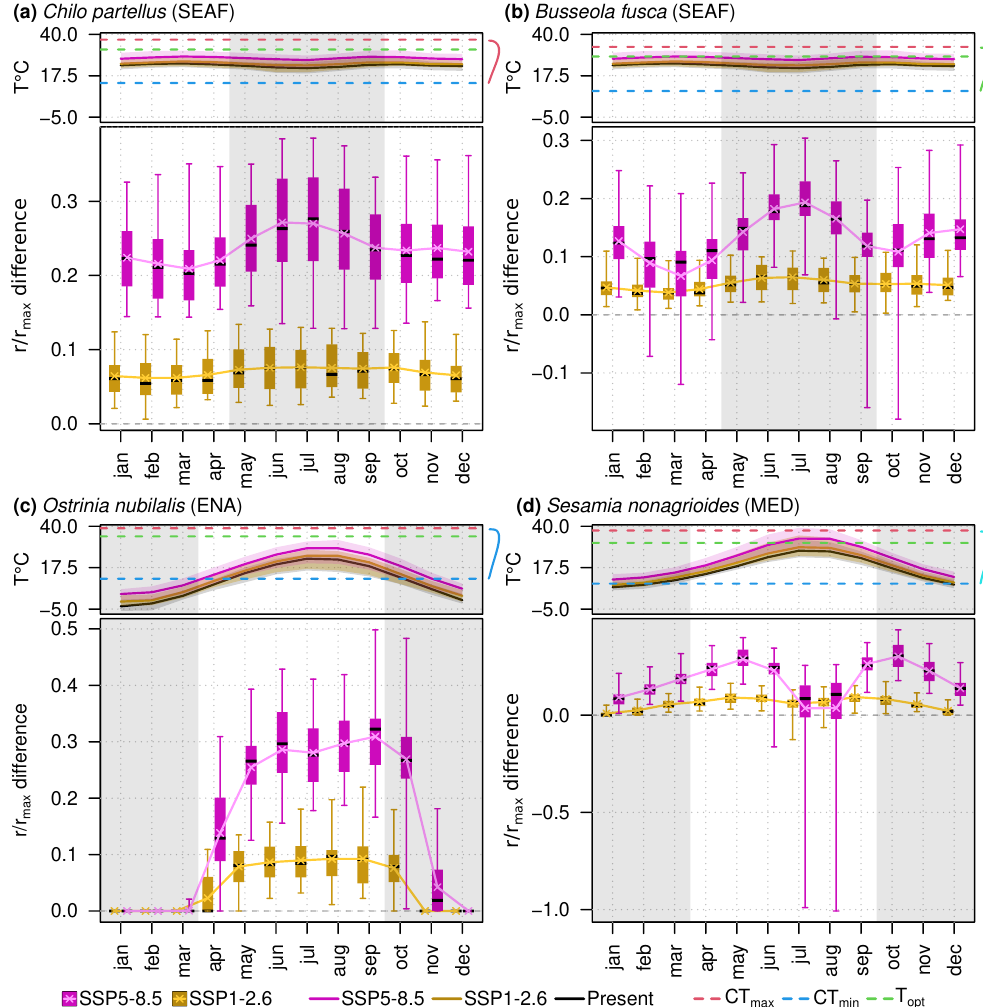
Figure 6. Influence of global warming on the development of ( a ) Chilo partellus , ( b ) Busseola fusca , ( c ) Ostrinia nubilalis , and ( d ) Sesamia nonagrioides . For each species, we predicted average devel- opment rates using mean monthly temperatures predicted by multiple Global Circulation Models (GCM) under current conditions (N = 35), and two future scenarios, SSP1-2.6 (N = 32) and SSP5-8.5 (N = 34), averaged over the region of reference where the species is present ( C. partellus and B. fusca : South-Eastern Africa, SEAF; O. nubilalis : East-North America, ENA; S. nonagrioides : Mediterranean region, MED). For each GCM, we averaged the monthly temperatures over 1990–2014 to represent current conditions, and 2081–2100 for future conditions. Monthly temperatures for each scenario are represented in the upper part, together with the area between minimal and maximal temperatures in transparency, and the species’ total development CT min (blue dashed line), T opt (green dashed line), CT max (red dashed line), and the development rate as a function of temperature in the right-hand